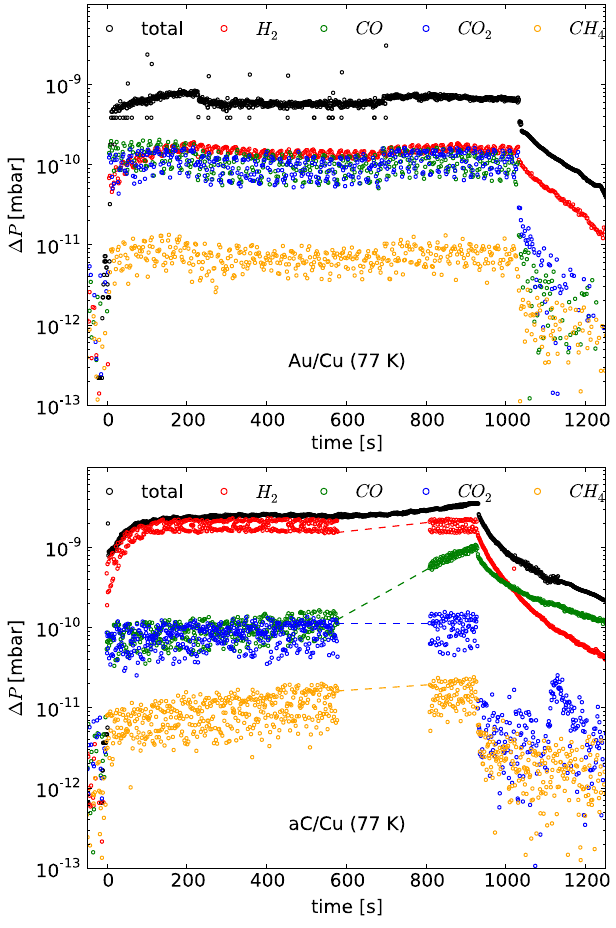
FIG. 6. Heavy-ion-induced pressure rises at 77 K target tem- perature. Partial pressure rises ( (cid:2) P ) of H 2 , CO, CO 2 , CH 4 , and total pressure rises measured for the Au = Cu and aC = Cu samples continuously bombarded under (cid:2) ¼ 0 (cid:2) with 1 : 4 MeV = u Xe 18 þ ions are